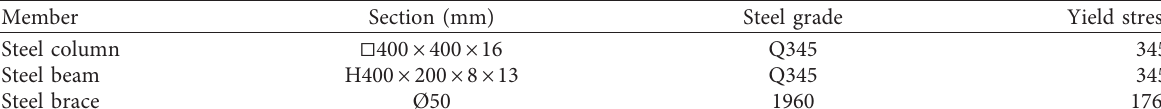
Figure 10: Member sections of the latticed shell. (a) Roof members; (b) boundary beam structure. Table 1: Steel member sections and yield stresses.